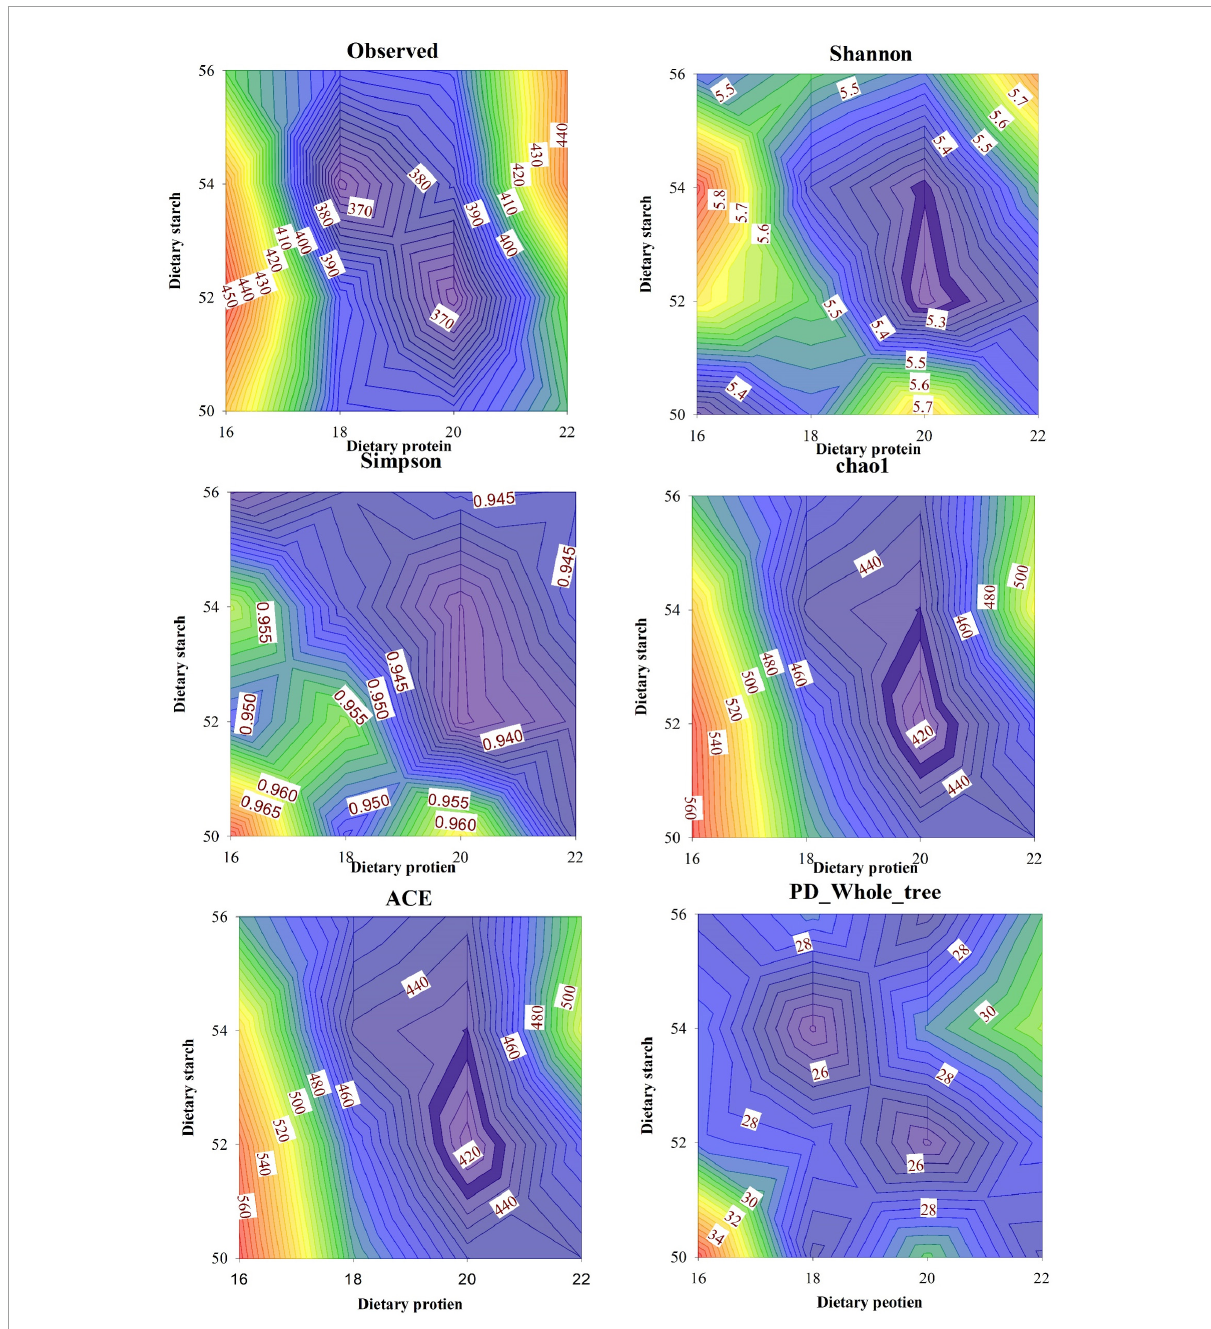
FIGURE5 Effects of different ratios of starch and protein in diet on α diversity in the fecal microbiota of mice. The value increases with the deepening of red and decreases with the deepening of blue.